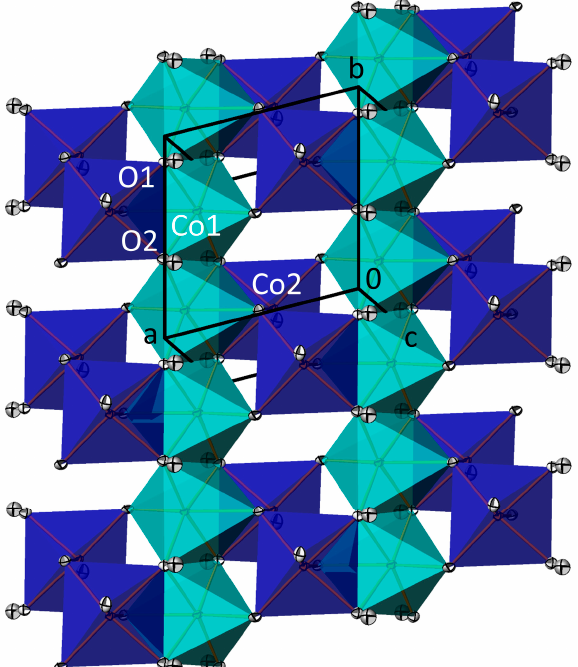
Figure 2. A perpendicular view of the 2 ∝ [Co 2 (OH) 6/3 O 3/3 O 2/2 O 1/1 ] 4 − layer in the crystal structure of Co 2 (TeO 3 )(OH) 2 . The [Co1O 6 ] octahedron is given in turquoise, the [Co2O 6 ] octahedron in dark blue. Atoms are displayed with anisotropic displacement ellipsoids at a 90% probability level.